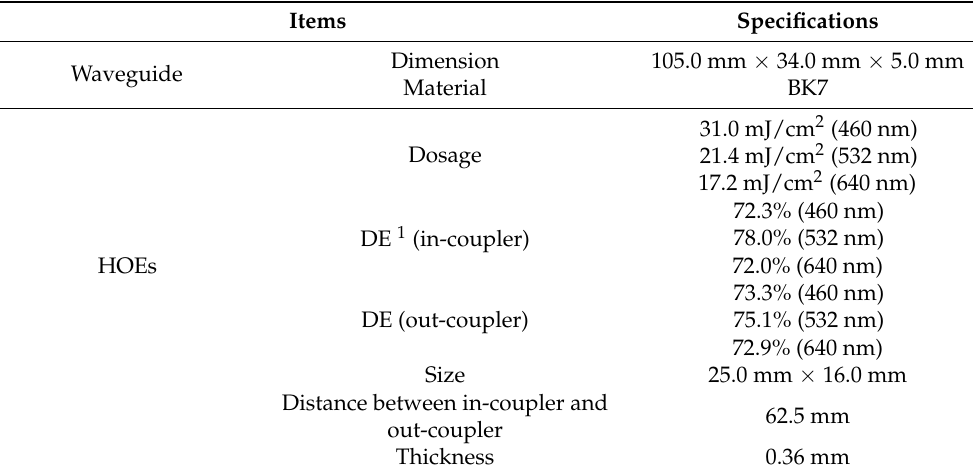
Table 1. Experimental specifications for fabricated holographic waveguide.